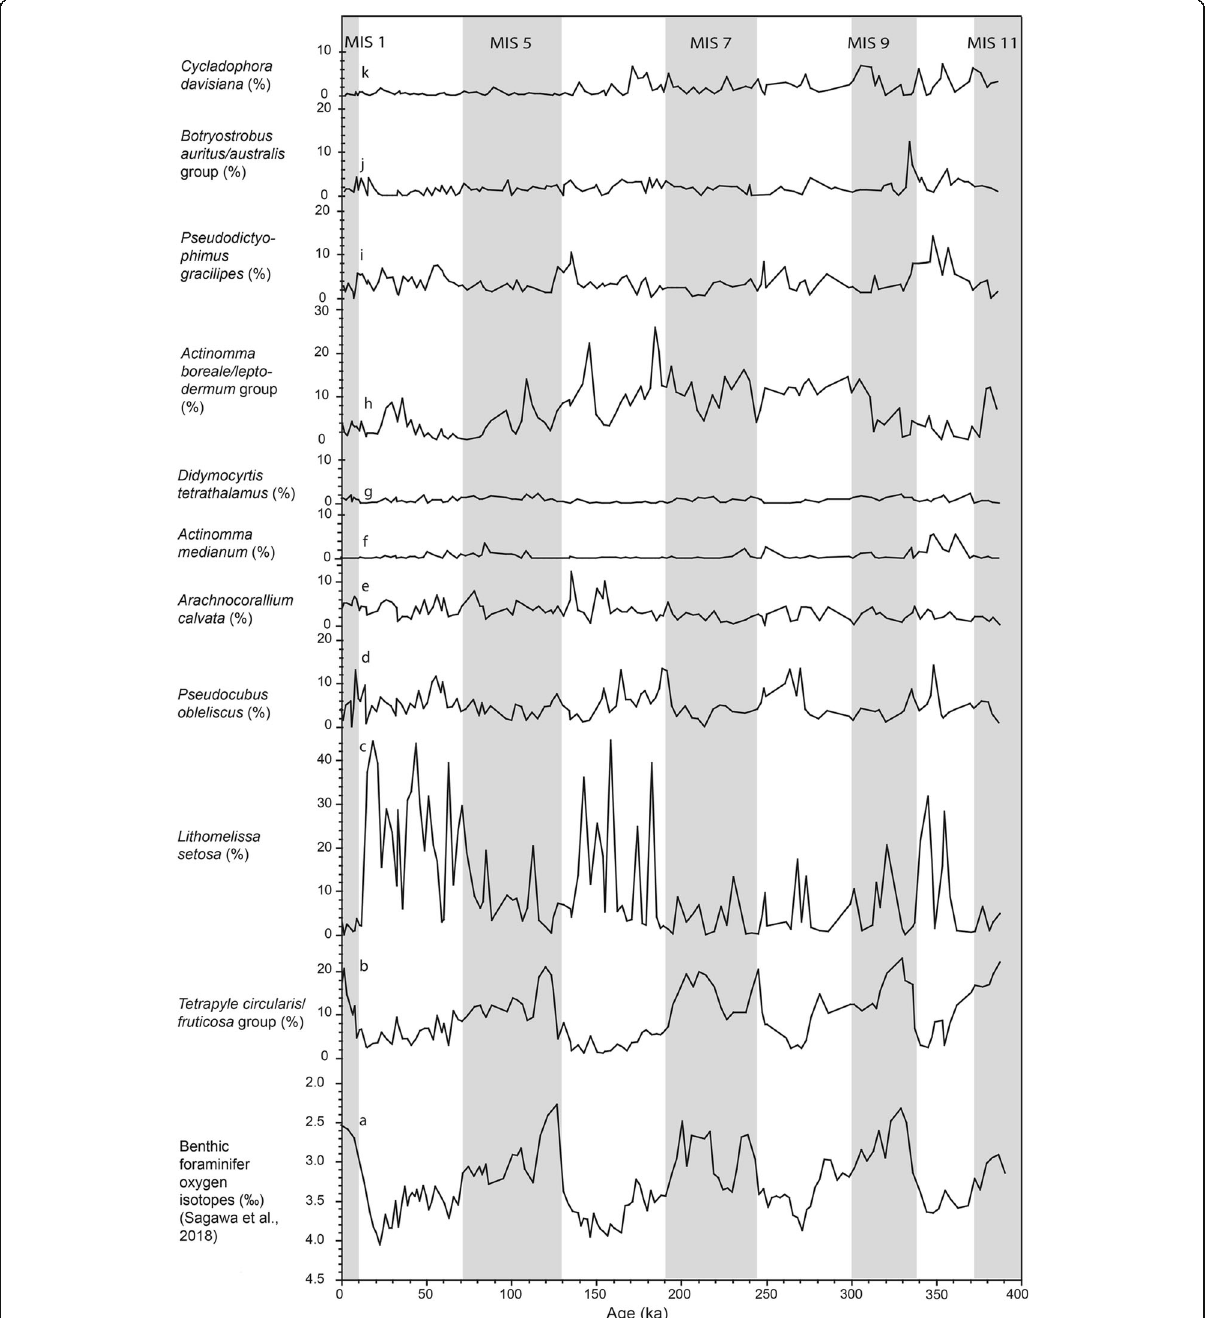
Fig. 5 Relative abundances of key radiolarian species encountered at Site U1429 over time, with comparison to the benthic foraminifer isotope curve of Sagawa et al.